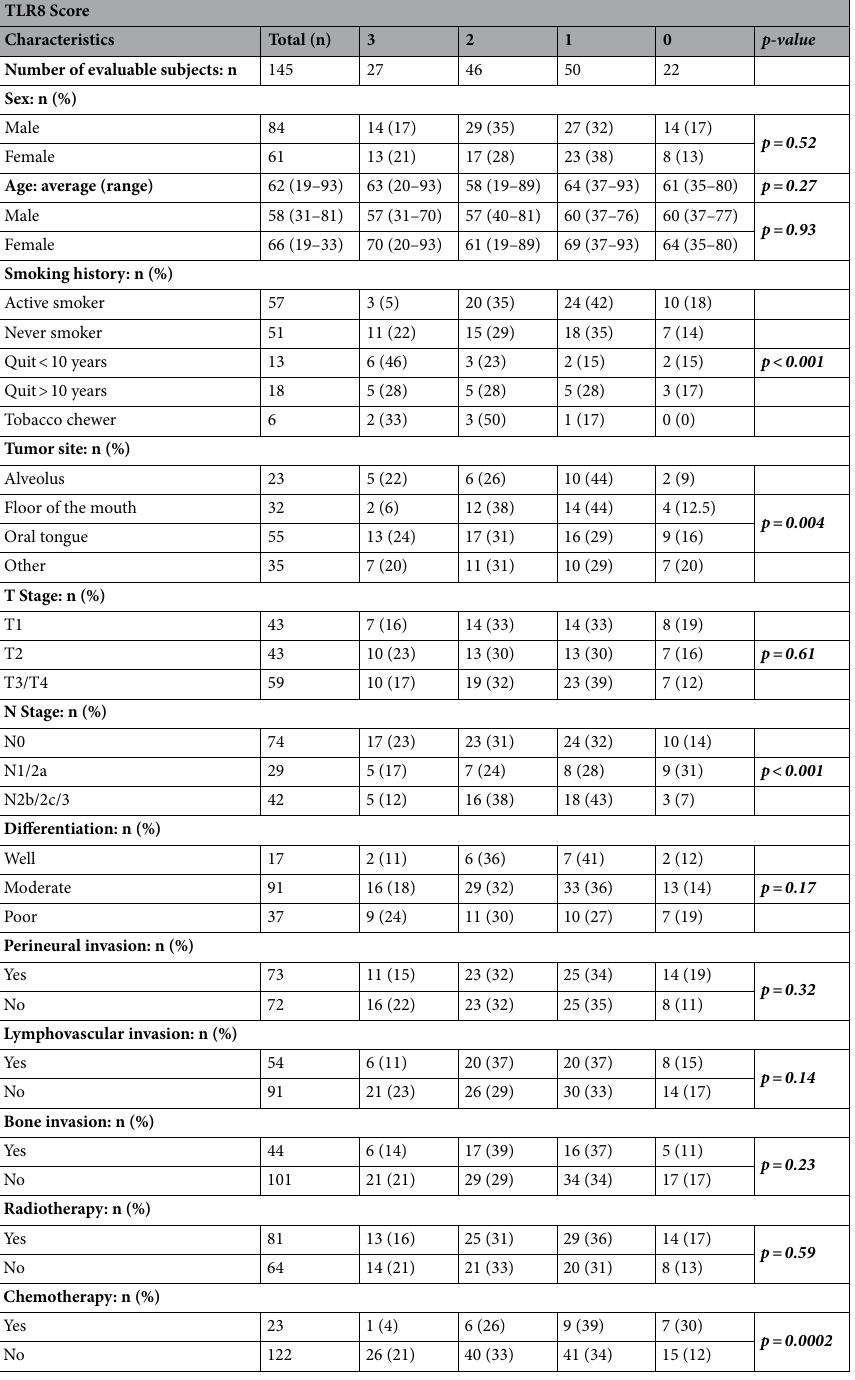
Table 1. Patient characteristics by TLR8